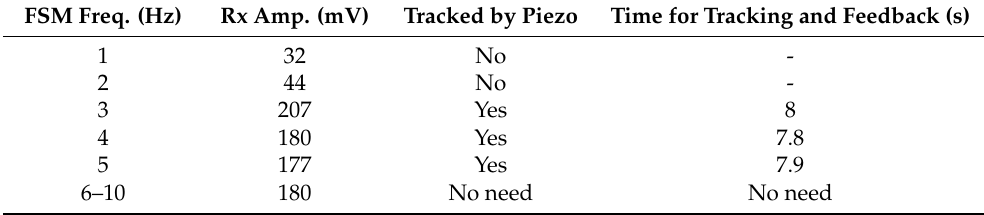
Figure 13. Illustration of vibration mitigation scheme for the OFDM-NOMA VLC system. Table 1. Performance of vibration mitigation scheme. FSM Freq.